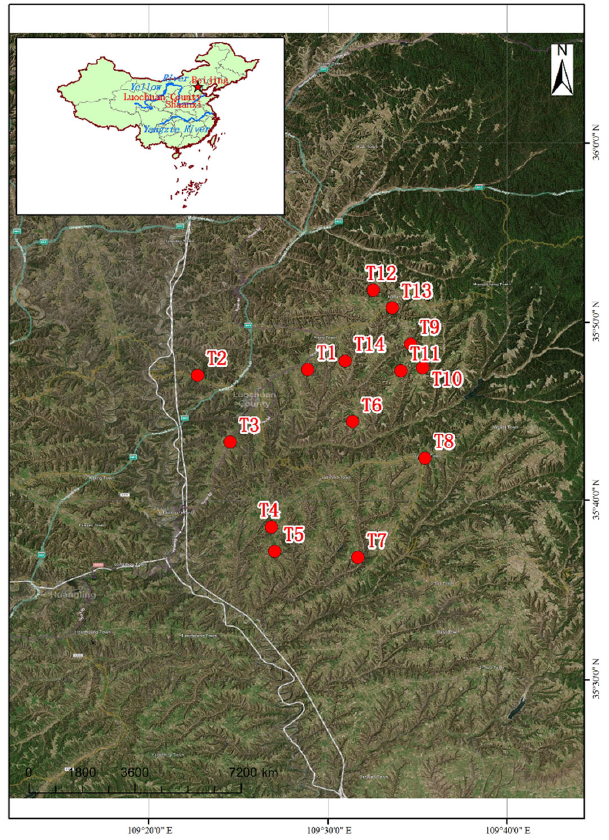
Figure 1. Collection sources of soil samples from 14 aged apple orchards in Luochuan County. Note: the red dot represents the sampling location, and the map was generated by ArcMap. T1: Gao Bao Village; T2: Lu Bai Village; T3: Bei Anshan Village; T4: Lunar Eclipse Village; T5: Bei Gu Village; T6: Yang Wu Village; T7: Bed Guang Rong Village; T8: Bai Jia Zui Village; T9: Northwest Ding Village; T10: Shang Cao Di Village; T11: Shang Huang Zhang Village; T12: Gu Xian Village; T13: Jing Yao Ke Village; T14: A Si Village.